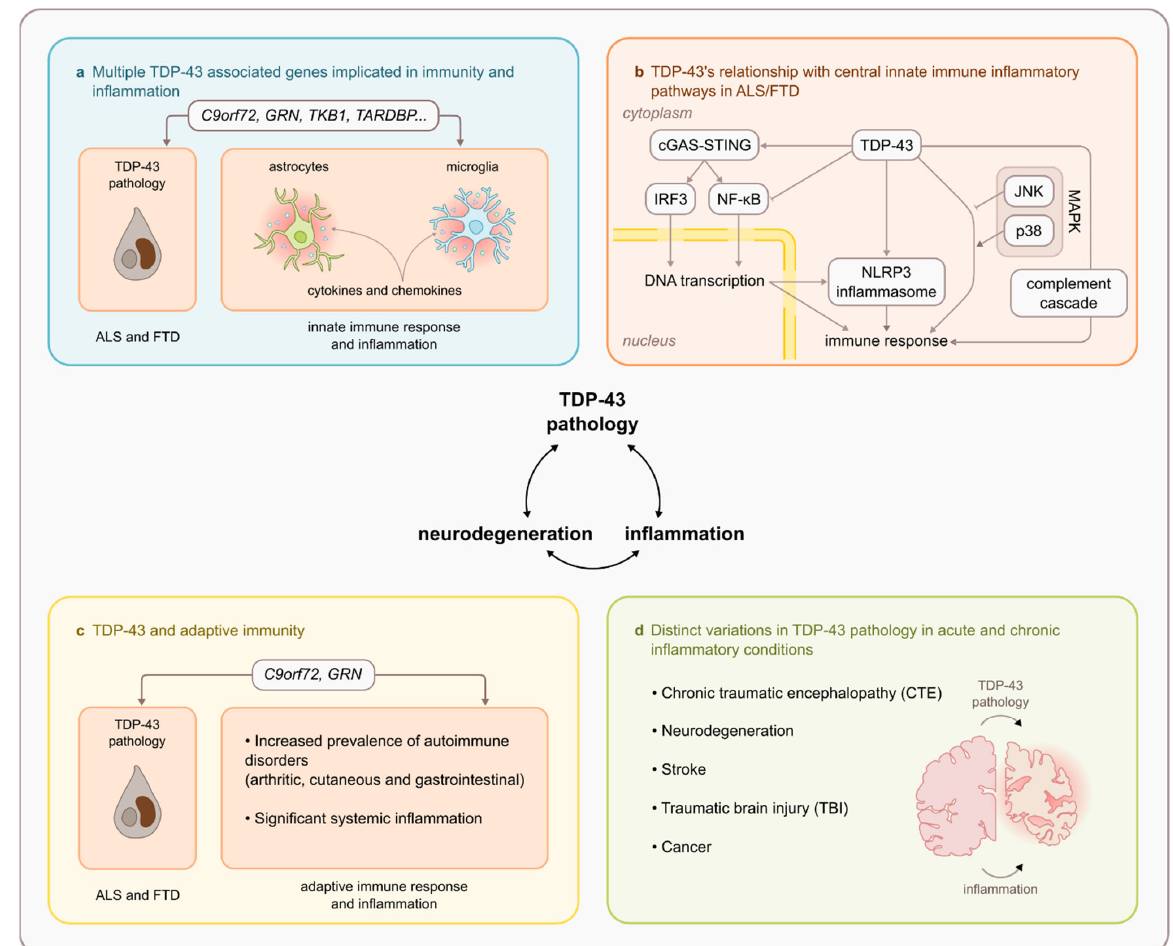
Figure 2. Four key lines of evidence for the specific relationship between TDP-43, immunity, and inflammation within the CNS. ( a ) Multiple ALS and FTD causative and susceptibility genes associated with TDP-43 pathology are directly implicated in immune and inflammatory pathways, notably C9orf72 , GRN , and TBK1 ; ( b ) demonstrated relationship between TDP-43 and central innate immune inflammatory pathways in ALS and FTD including NF- κβ /p65, cGAS/STING, NLRP3 inflammasome, MAPK/JNK/p38, and the complement cascade; ( c ) altered adaptive immunity that is intrinsically linked to TDP-43 pathophysiology, specifically in FTD and ALS C9orf72 repeat expansion and GRN mutation carriers; ( d ) the presence and role of TDP-43 pathology in other acute and chronic inflammatory CNS conditions including stroke, TBI, CTE, and cancer (not discussed in this review). Taken together this evidence points towards a robust and specific relationship between TDP-43, immunity, and inflammation that may provide a platform for the identification of novel immune-mediated targets associated with TDP-43 to aid in discovery and generation of disease-modifying therapies for ALS and